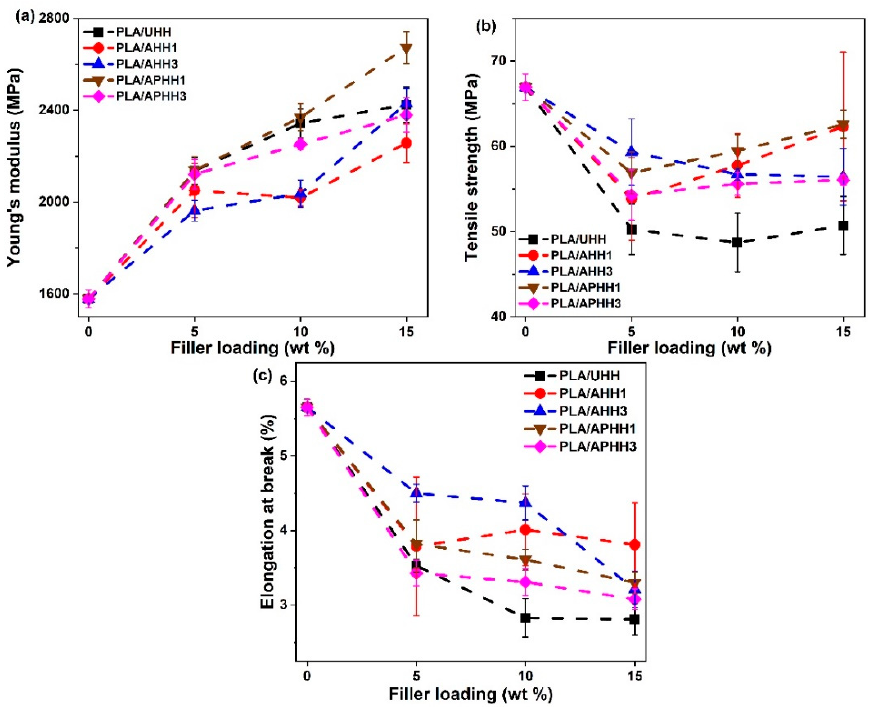
Figure 8. Young’s modulus ( a ), tensile strength ( b ), and elongation at break ( c ) of PLA biocomposites for 5, 10, and 15 wt. % filler loading (note: average values and standard deviation of five independent measurements are shown; lines are drawn solely in the interest of clarity) .